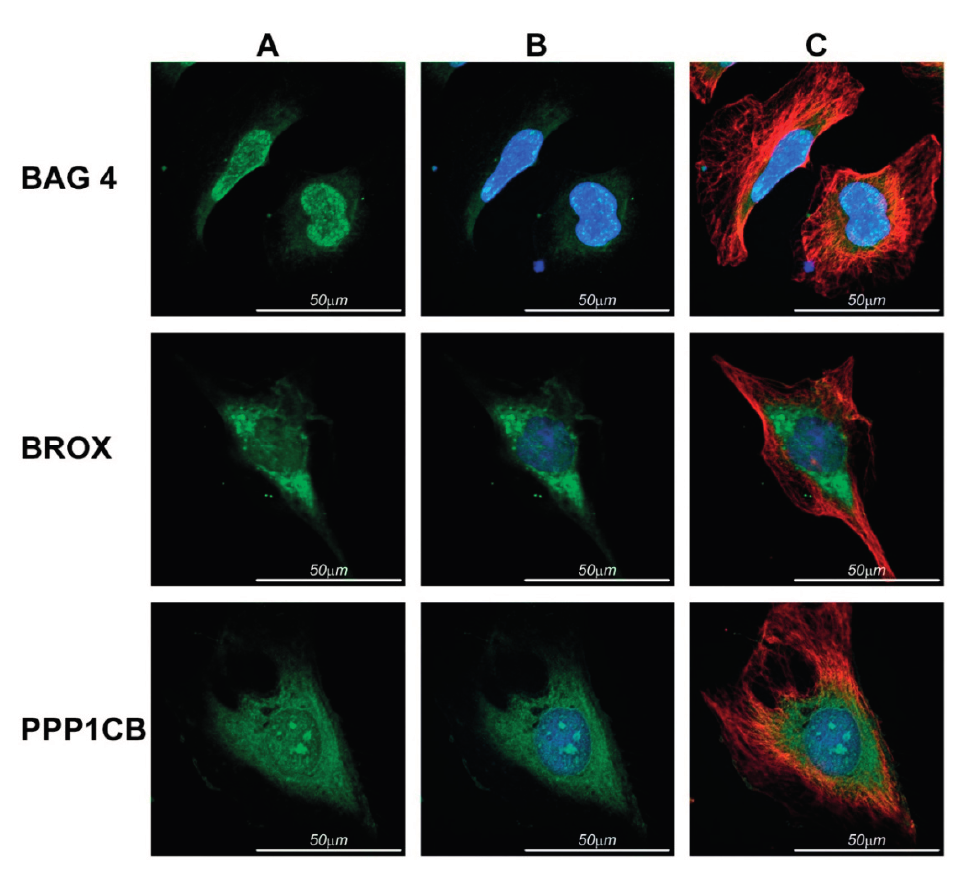
Figure 3. Subcellular localization of BAG4, Brox and PPP1CB in non-transfected HeLa cells. ( A ) Studied proteins using specifics antibodies are shown in green; ( B ) merge of studied proteins (green) and nucleus (blue) labeled with DAPI; ( C ) merge of studied proteins (green), nucleus (blue) and β tubulin